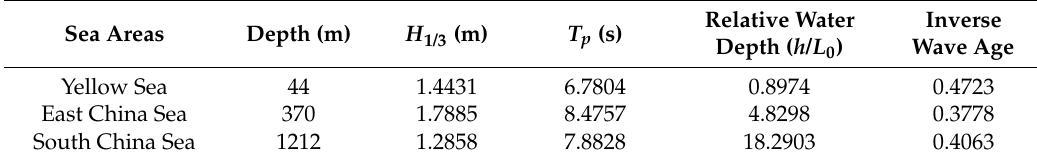
Table 4. The relative water depth and wave parameters for wind speed of 5 m/s.